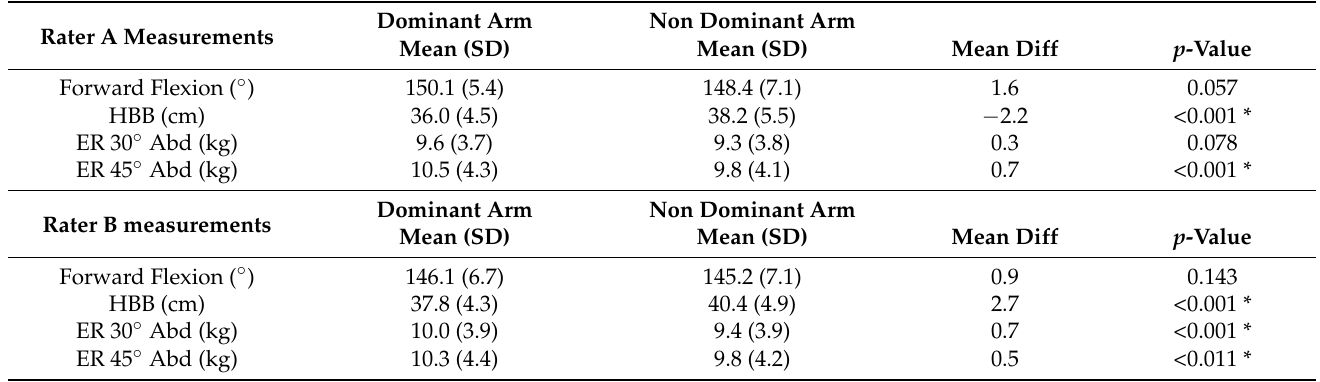
Table 5. Rater A and B shoulder measurement comparisons by arm dominance (n =